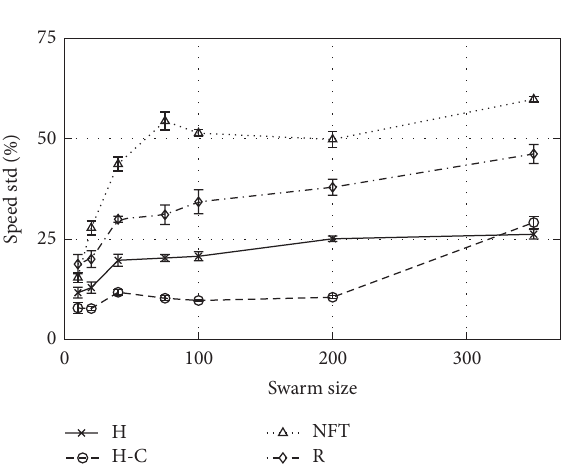
Figure 11: Average peer delay in Scenario